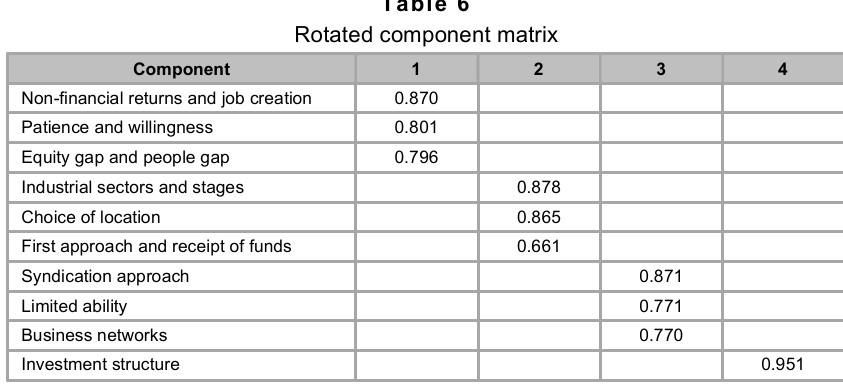
Rotated component